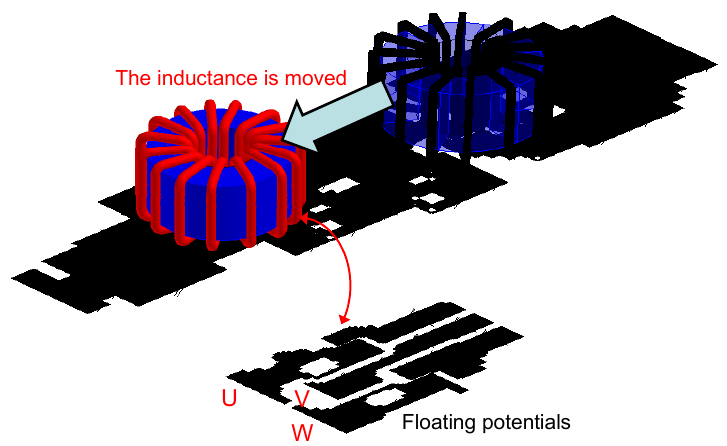
Figure 9. Two positions of the common mode inductance.